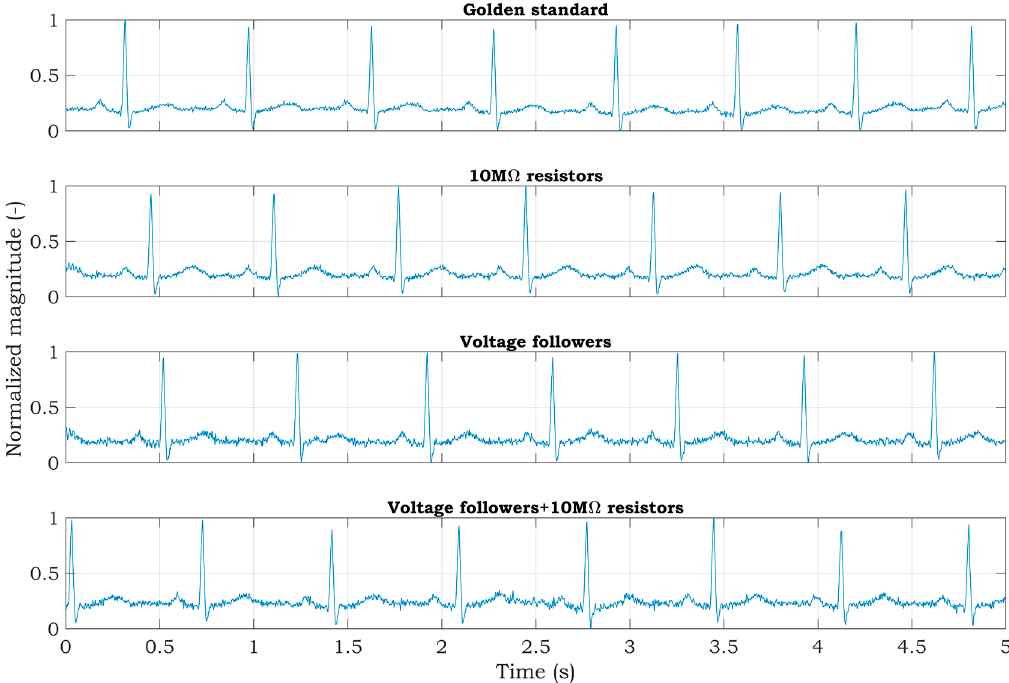
Figure 13. Application of a digital notch filter to ECG signals measured from a living subject.